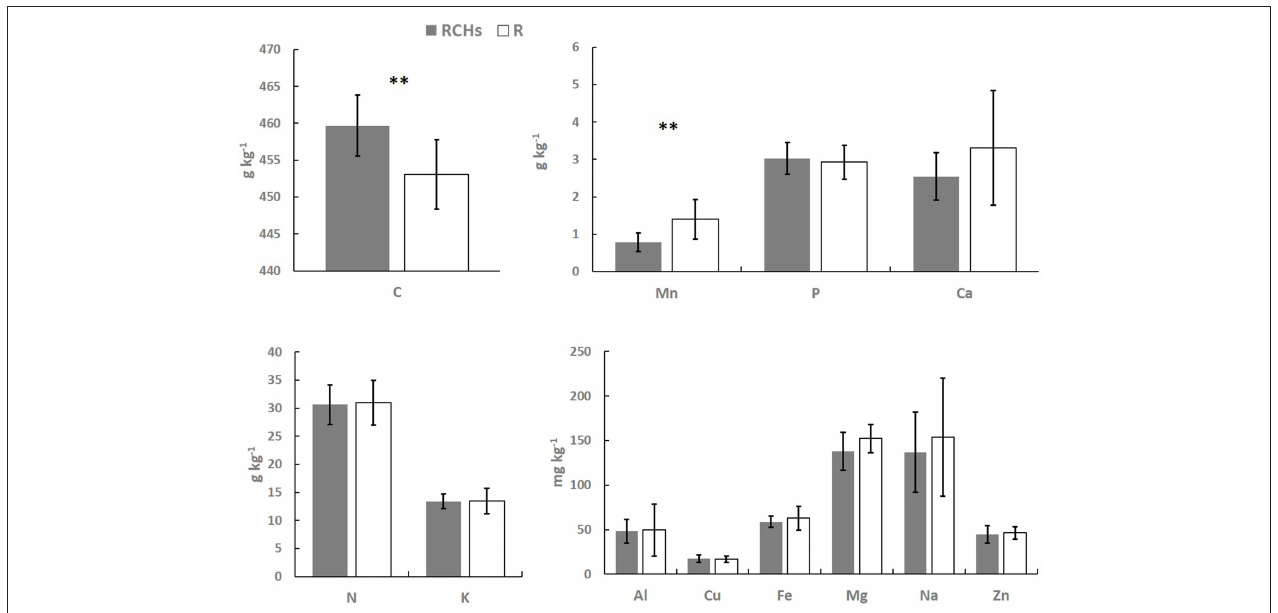
FIGURE 3 | Elements concentration in European beech leaves (dry mass) from relic charcoal hearths (RCHs) and reference (R) plots. Bars represent mean values and error bars represent standard deviation ( n = 9). Differences between nutrients concentration from trees inside and outside RCH plots were tested by t -test (** p < 0.01).